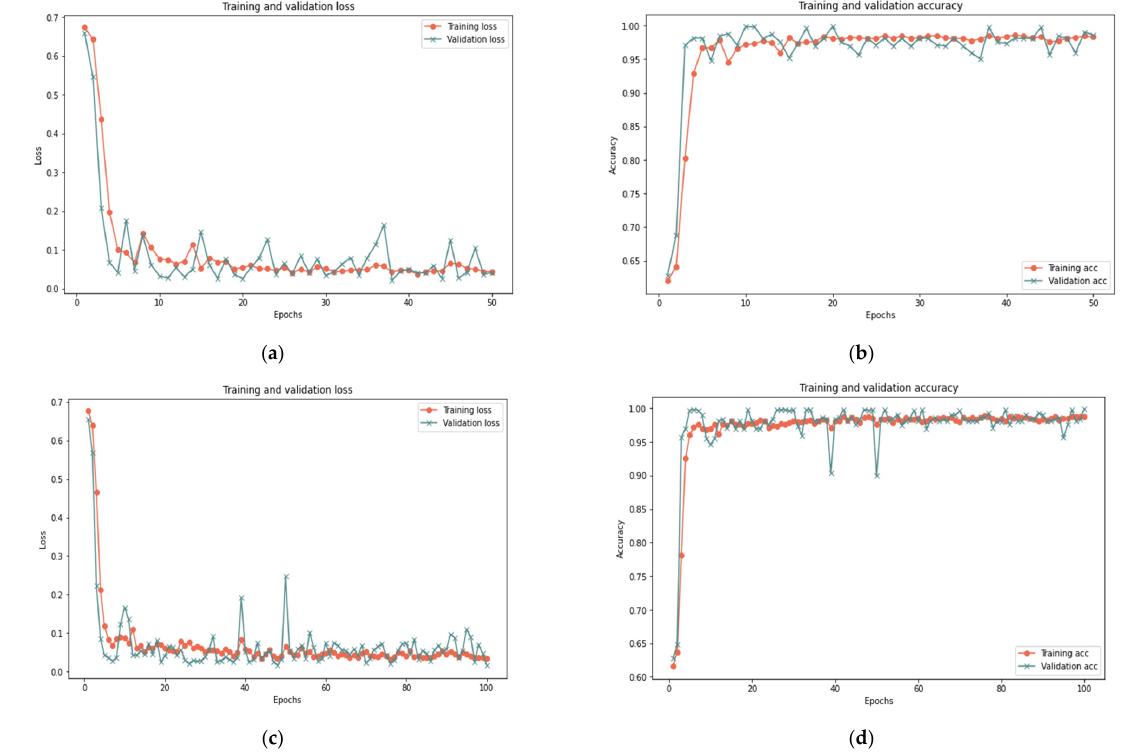
Figure 8. Results of the 50% sample size: ( a ) loss at 50 iterations; ( b ) accuracy at 50 iterations; ( c ) loss at 100 iterations; and ( d ) accuracy at 100 iterations.